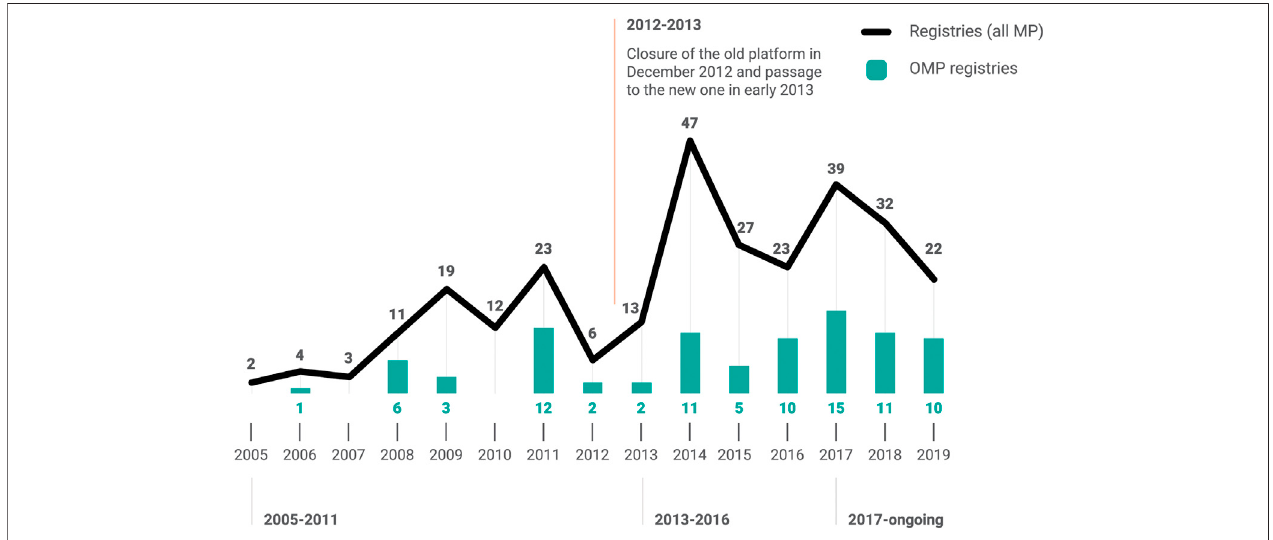
FIGURE 2 | The incidence of AIFA registries. MP, medicinal product; OMP, orphan medicinal product.